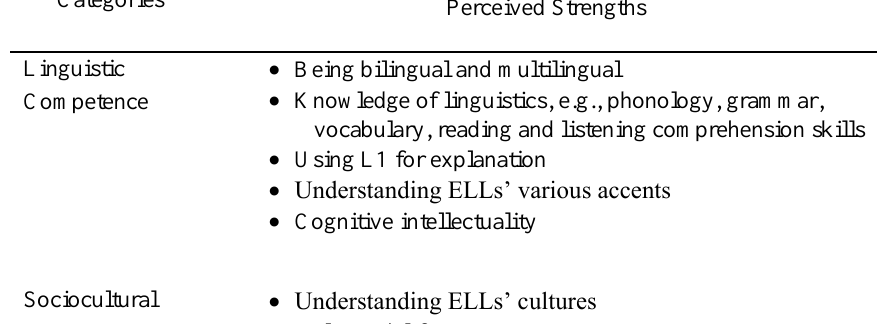
NNESTs’ Perceived Strengths Reported by Participating Teachers Categories Perceived